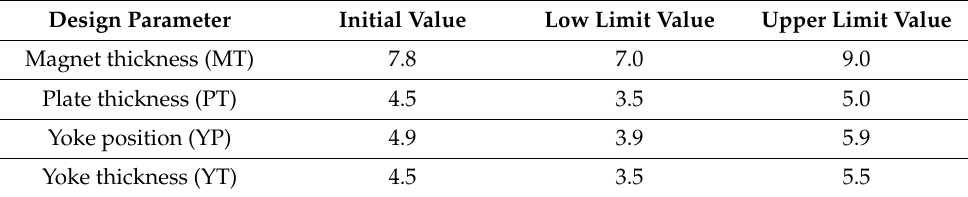
Table 2. Range of design variable dimensions for vertical magnetized structure. (unit: mm). Design Parameter